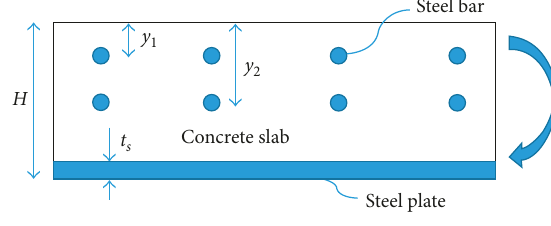
Figure 25: Calculation section of the specimen.